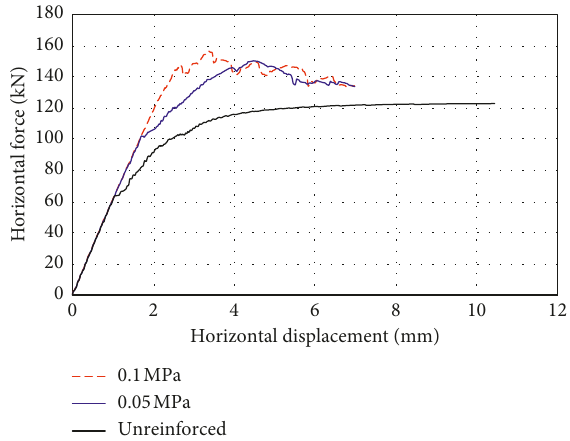
Figure 4: Relationship between horizontal force and horizontal displacement for the one-storey RE wall.